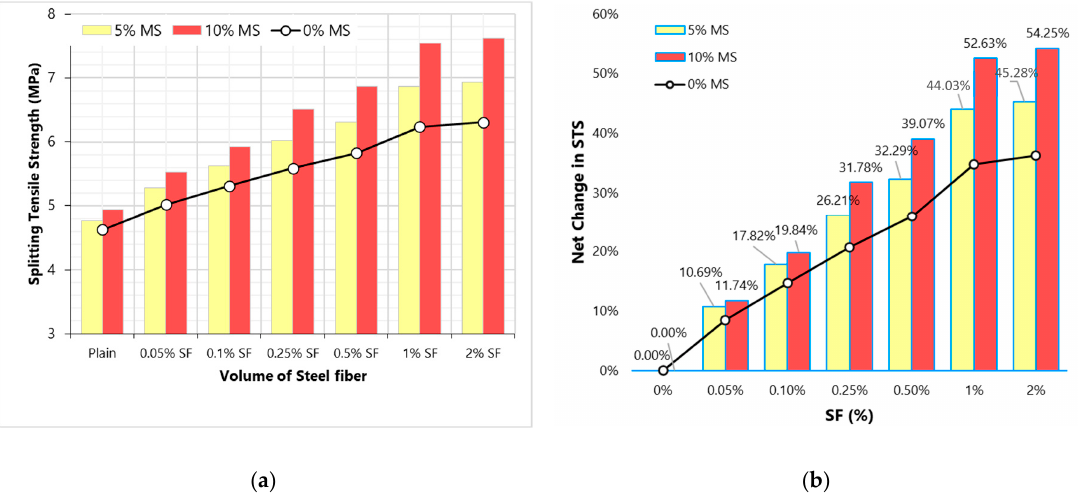
Figure 9. Splitting-tensile strength (STS) results ( a ) effect of MS on STS with varying SF dosage ( b ) effect of MS on the net change in STS with varying SF dosage.